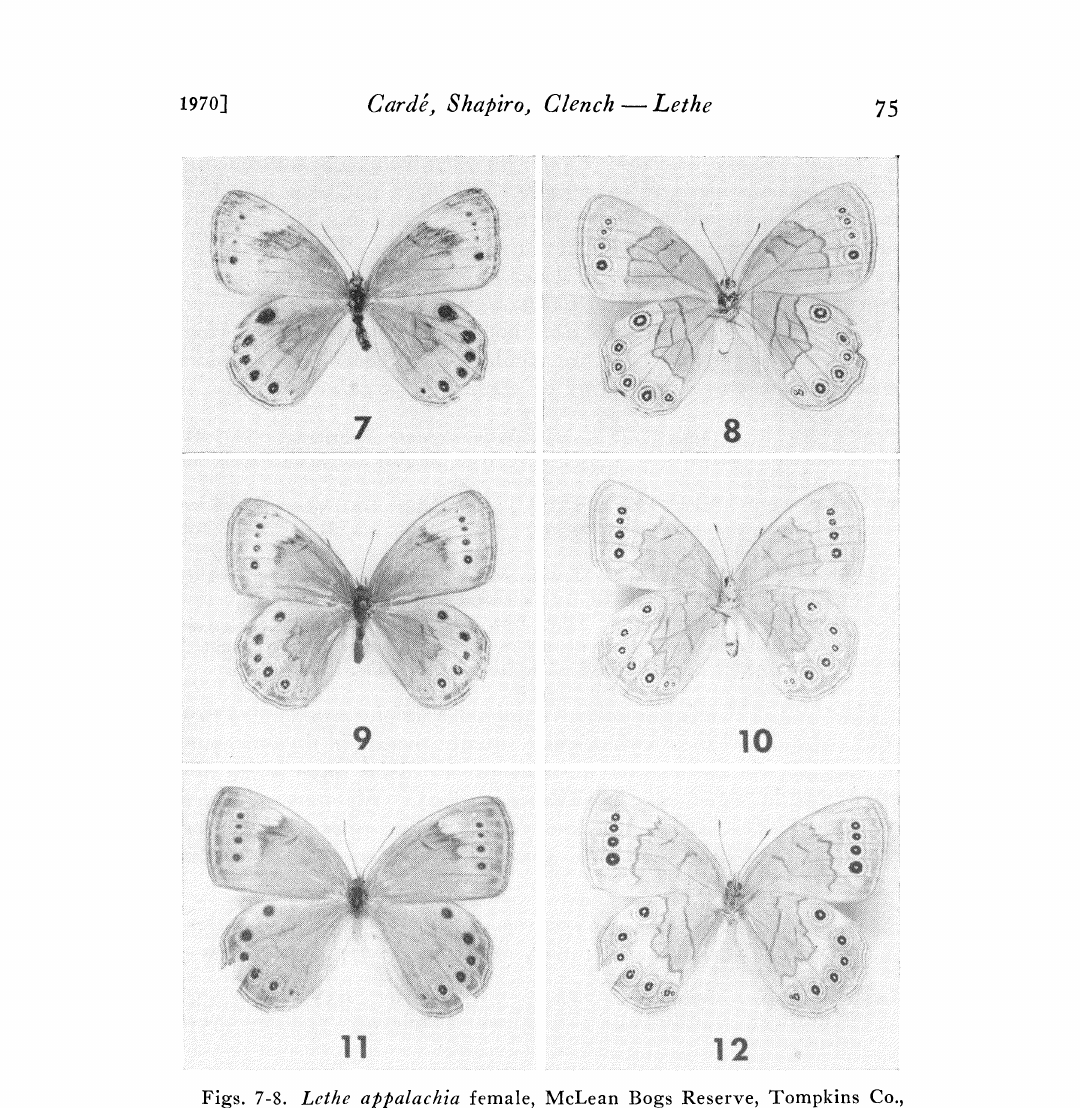
Figs. 7-8. Lethe appalachia female, McLean Bogs Reserve, Tompkins Co., New York. Figs. 9-10. Lethe eurydice eurydice female, McLean Bogs Re- serve, Tompkins Co., New York. Figs. 11-12. Lethe eurydice fumosa fe- male, Sarpy Co.,